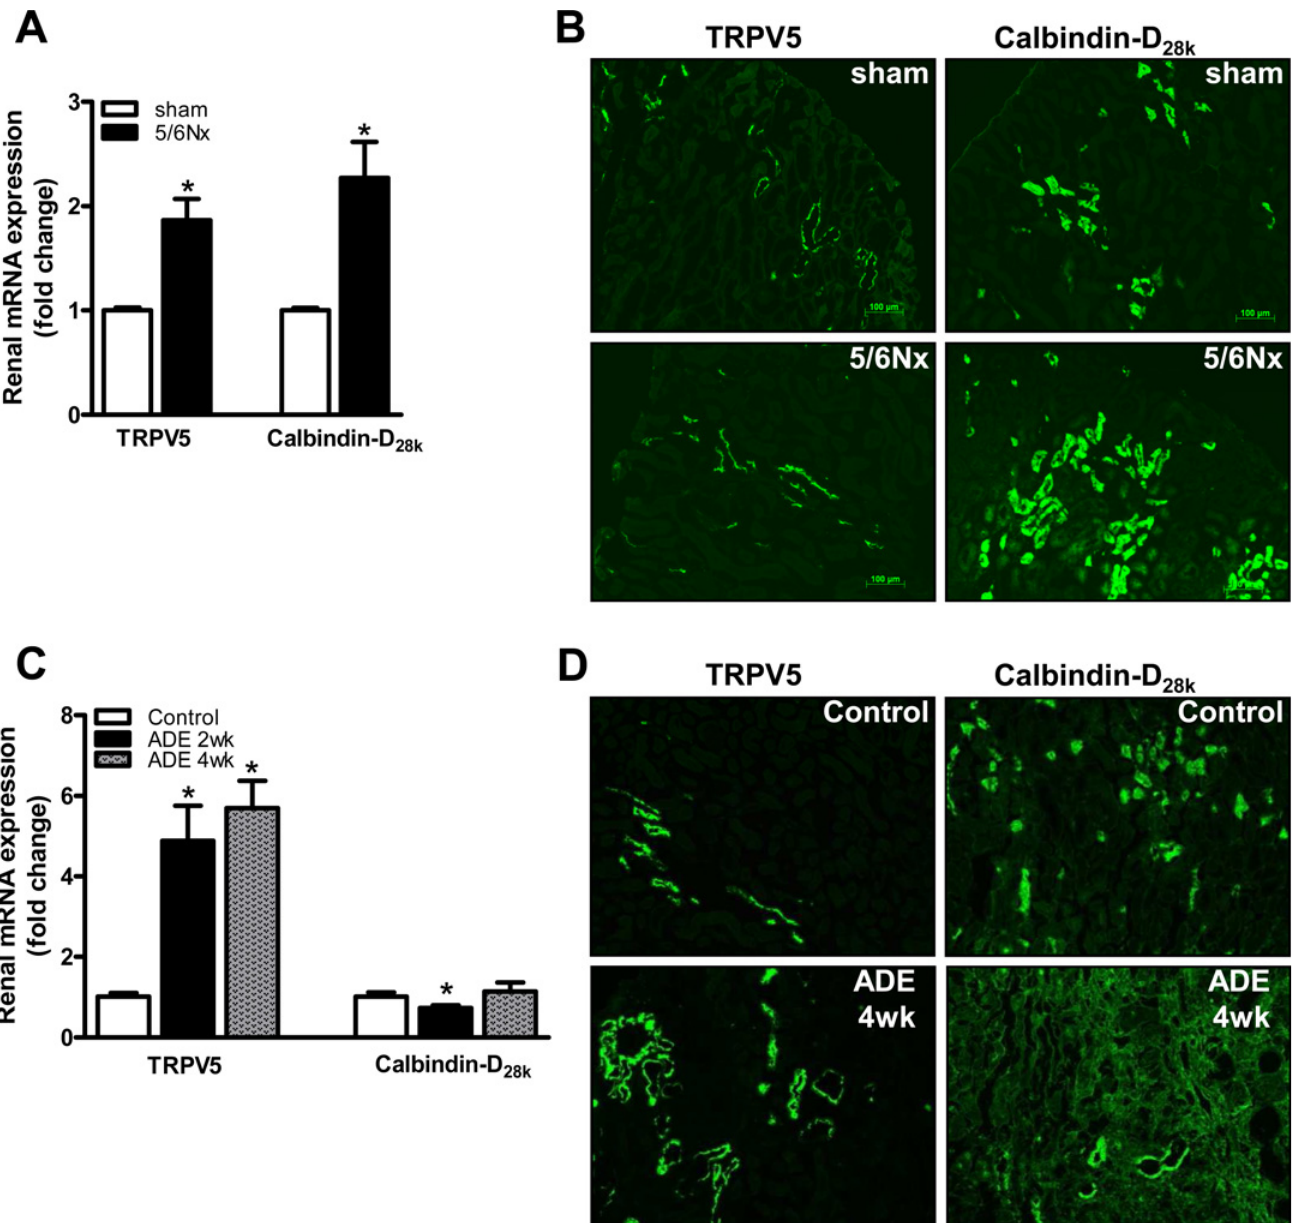
Fig 4. CKD development increased expression of tubular calcium transporters. (A) mRNA expression of the renal apical Ca 2+ transporter TRPV5 and intracellular calcium shuttling protein calbindin-D 28K in the CKD induced 5/6Nx mice (black bars) compared to sham-operated mice (white bars). (B) Representative microphotographs for renal TRPV5 and calbindin-D 28K protein expression in kidney tissue from CKD induced 5/6Nx mice and sham-operated mice. (C) mRNA expression of the renal apical Ca 2+ transporter TRPV5 and intracellular calcium shuttling protein calbindin-D 28K in mice fed with ADE diet for 2 weeks (black bars) and 4 weeks (gray bars) compared with control diet fed mice (white bars). (D) Representative microphotographs for renal TRPV5 and calbindin-D 28K protein expression in kidney tissue from CKD induced ADE treated (4 weeks) and control mice. Bars represent 100 μ m. Data are mean ± SEM. * : p < 0.05 compared to either sham-operated or control